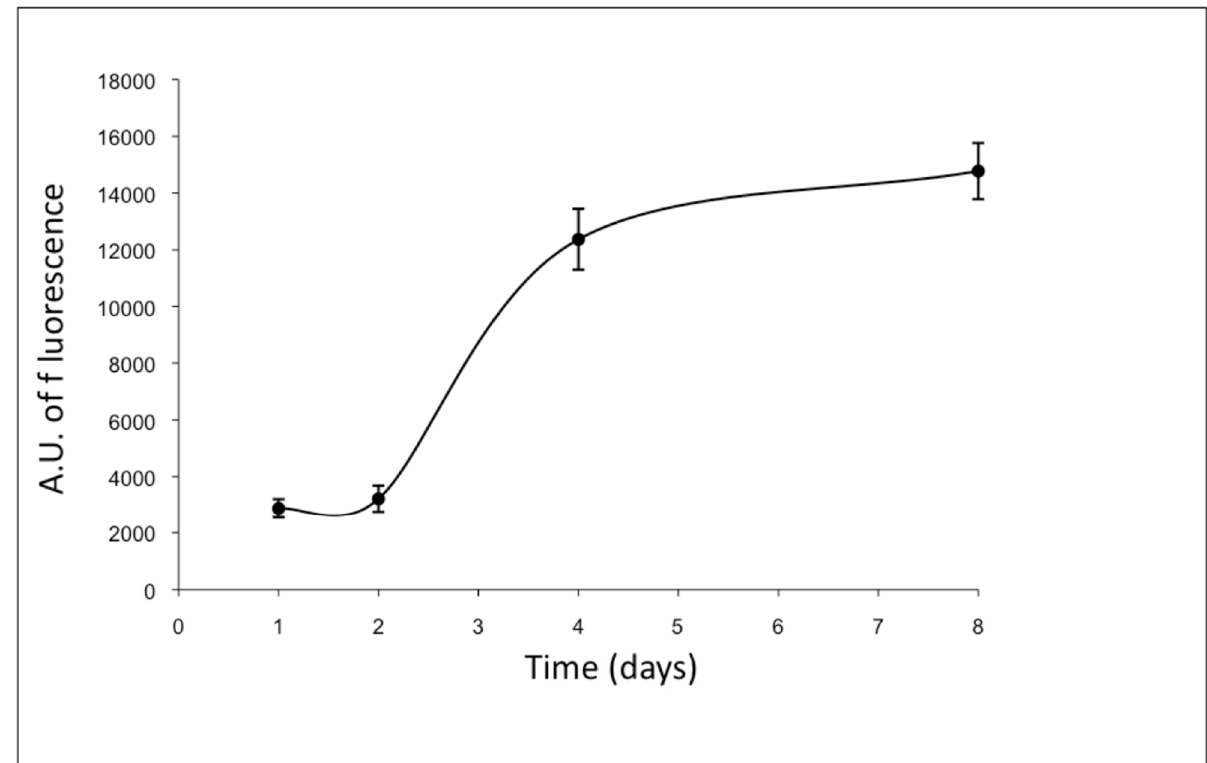
Figure 3. Proliferation curve of ad-MVF embedded in type-I collagen 3D hydrogel (Almar blue assay). Cells began to actively proliferate from the second day of culture and reached the capillary network after 8 days. The fluorescence values were expressed as arbitrary units